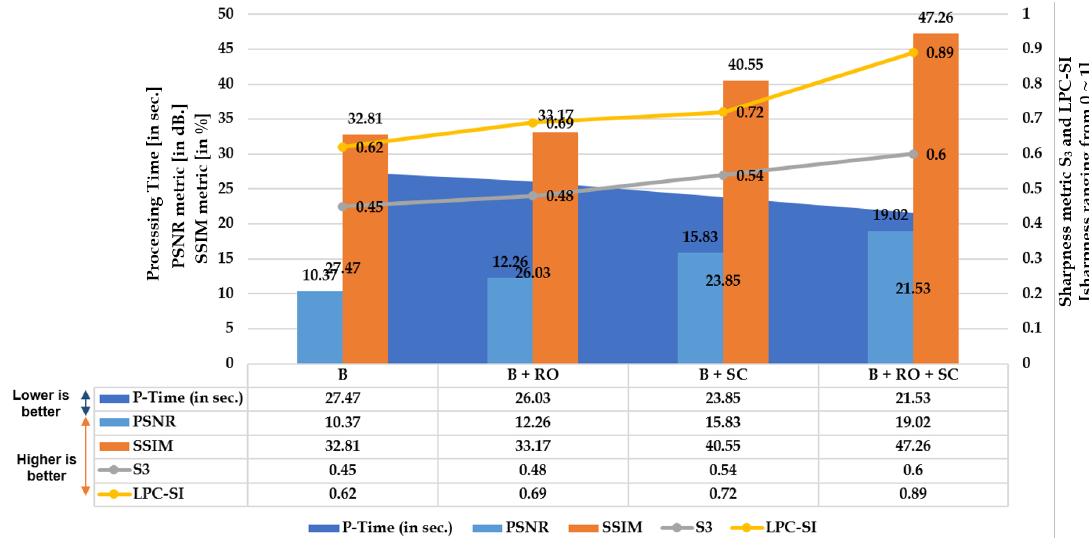
Figure 4. Quantitative: Significance of proposed cumulative set aggregation loss and refinement scheme with respect to image quality, edge stretching, and processing time on distorted KITTI